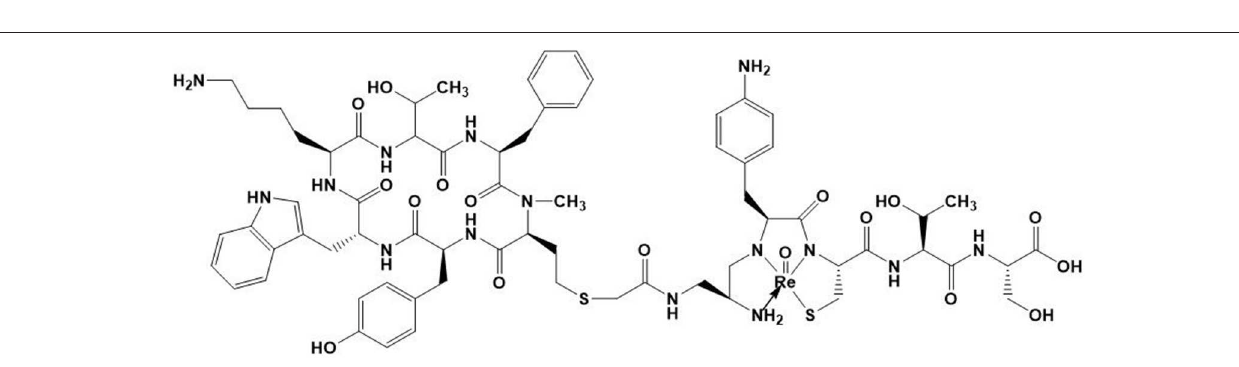
FIGURE 6 | Structure of 188